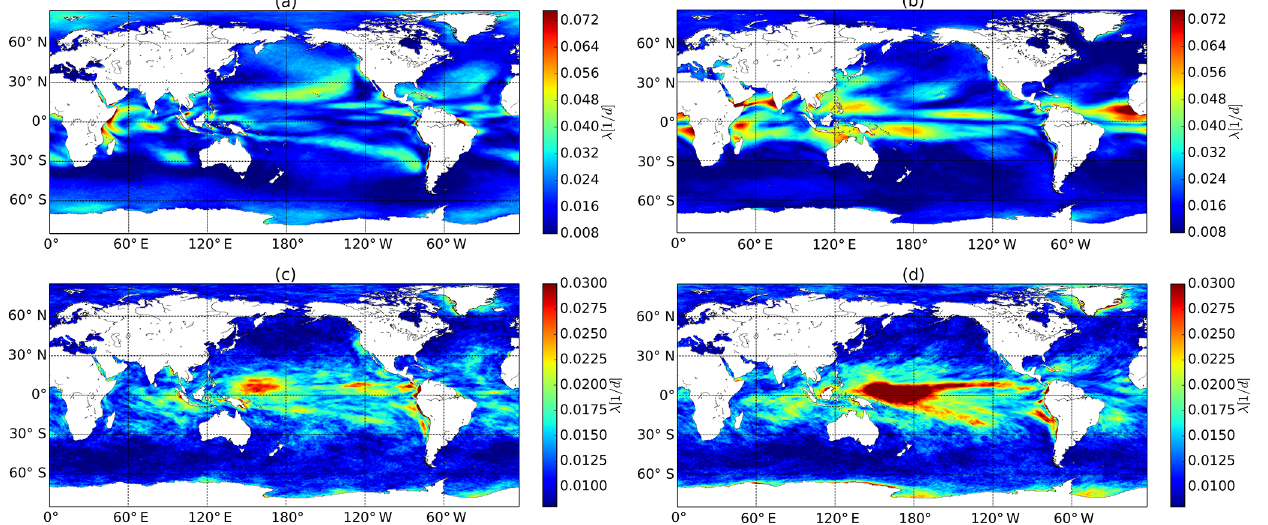
Figure 3. Seasonal dependence of the finite-time Lyapunov exponents calculated for the 1979–2014 period. Intra-annual variability in the forward (a) and backward (b) FTLE, respectively. Interannual variability in the forward (c) and backward (d) FTLE, respectively. For all cases, τ = 5 days.